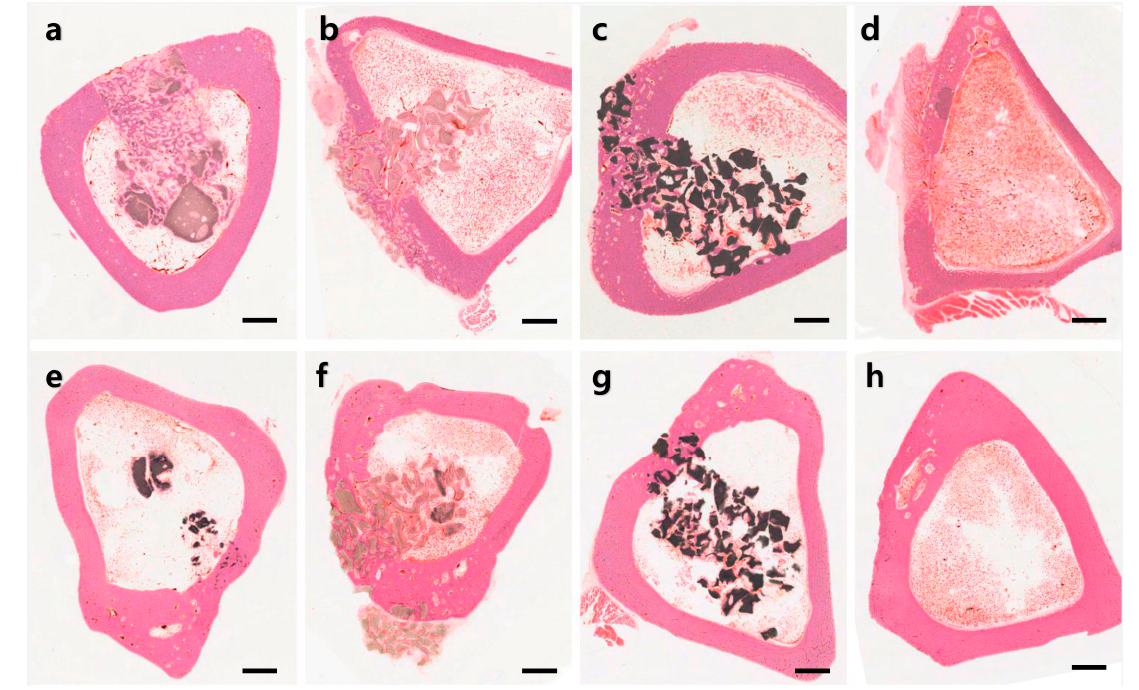
Figure 3. Tibias at four weeks ( a – d ) and 12 weeks ( e – h ) after implants with OCP ( a , e ), BHA ( b , f ), BCP ( c , g ), and CON ( d , h ) materials. The sample was resin embedded and ground to a 15 μ m thickness. H-E stain was used. The bars indicate 2 mm.